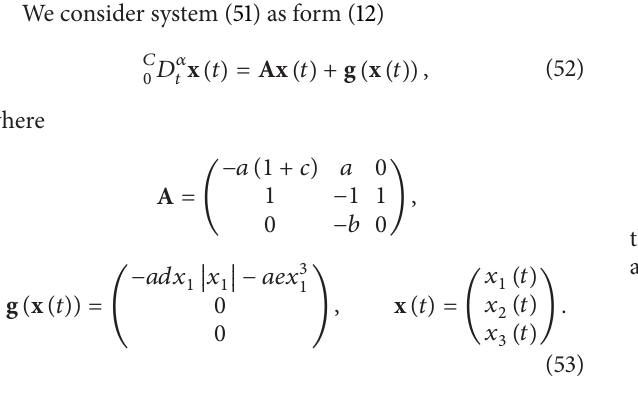
where ℎ(𝑥 1 ) = 𝑐𝑥 1 + 𝑑𝑥 1 |𝑥 1 | + 𝑒𝑥 3 1 . When the parameters are chosen as 𝑎 = 12.8 , 𝑏 = 19.1 , 𝑐 = −0.4 , 𝑑 = −1.1 , 𝑒 = 0.45 , and 𝛼 = 0.99 , system (55) exhibits the chaotic behavior, as shown in Figure